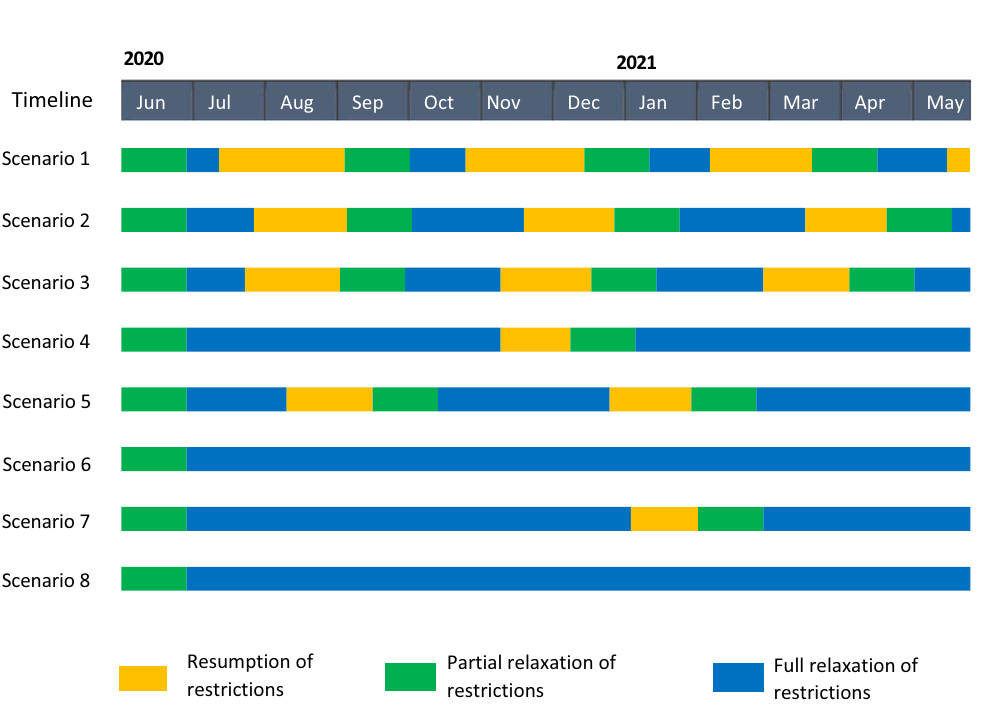
Table 3. Estimated effective reproduction numbers (R t ) after full reopening under the different adherence to social distancing and mask-wearing. *Social distancing is equivalent to keeping 6 feet distance from others. IQR Interquartile Range.